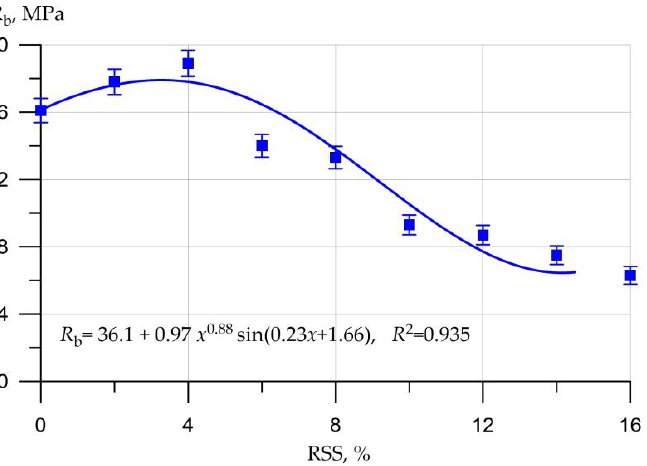
Figure 5. Results of investigational studies of the influence of local replacement of CA with RT seed shells on axial CS b R .